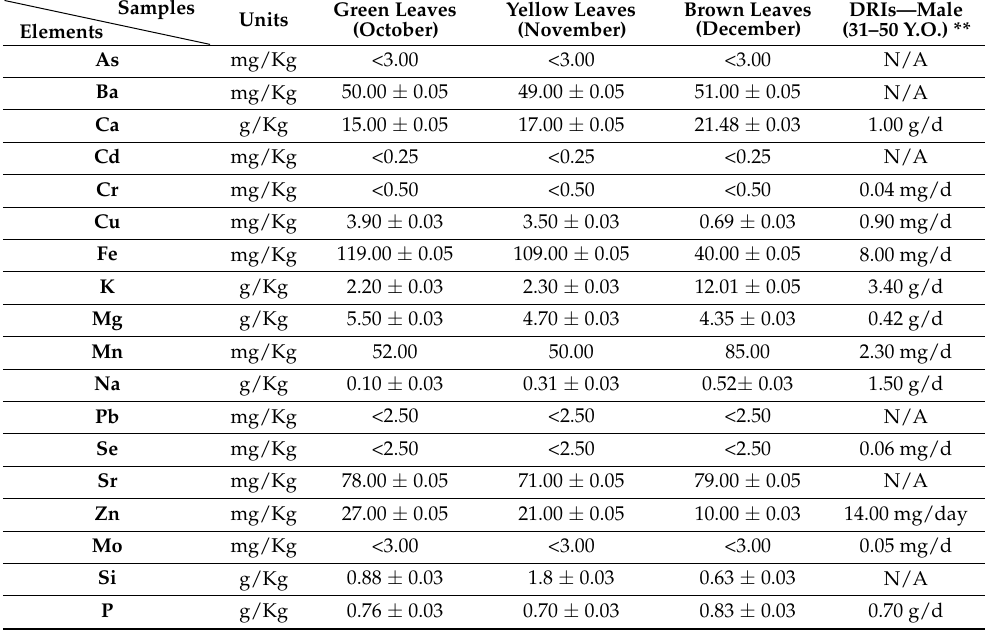
Table 1. Mineral analysis of leaf samples of Cydonia oblonga Mill—green leaves in October, yellow leaves in November, and brown leaves in December. Each sample group was made by a mix of different tree leaves to obtain an approximate biological average. As a result, present results express a mean ± reading deviation ( n = 3) which varies between a 3.0–5.0% gap. ** DRIs (daily recommended intake)—https://www.nap.edu (accessed on 30 October